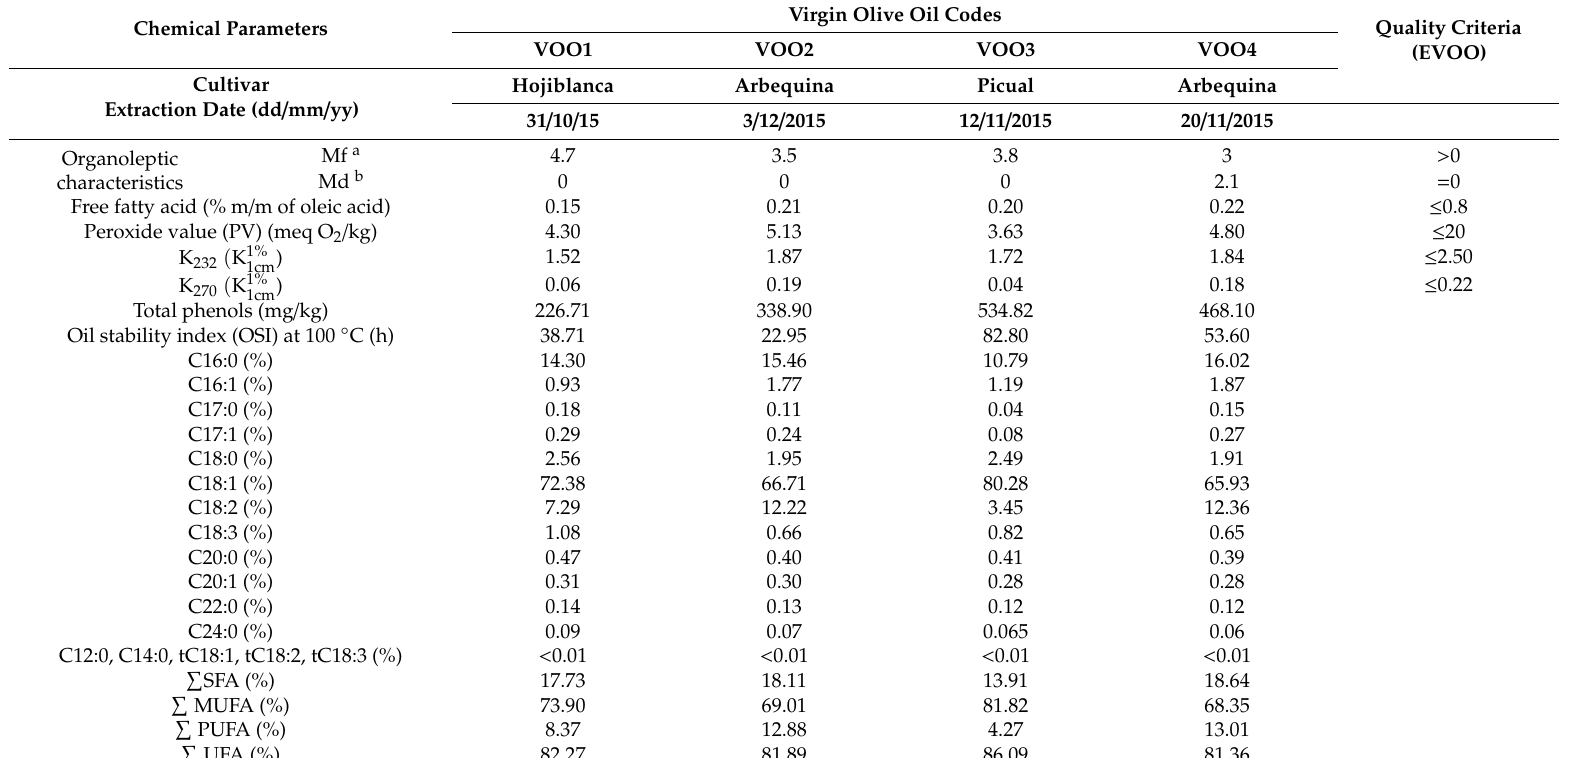
Table 1. Quality parameters, together with the quality criteria of extra virgin olive oil (EVOO) according to EC regulation No 2568 / 91 and updates; stability index, fatty acid composition and total phenol content in the fresh virgin olive oils, before of the bottling. The virgin olive oil codes, dates of the extraction and the cultivars are